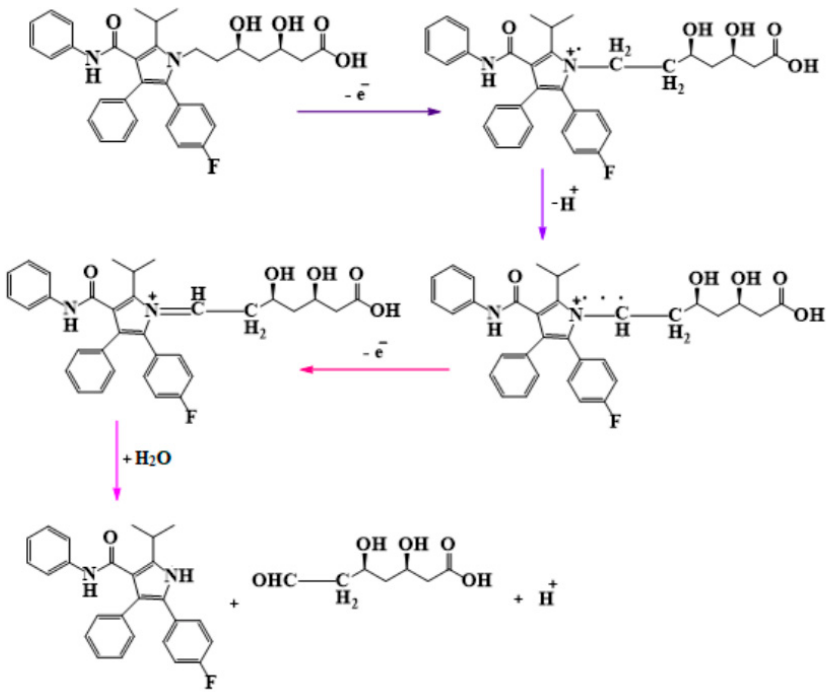
Figure 4. Mechanism proposed for electrochemical oxidation of atorvastatin. Adapted from [34].